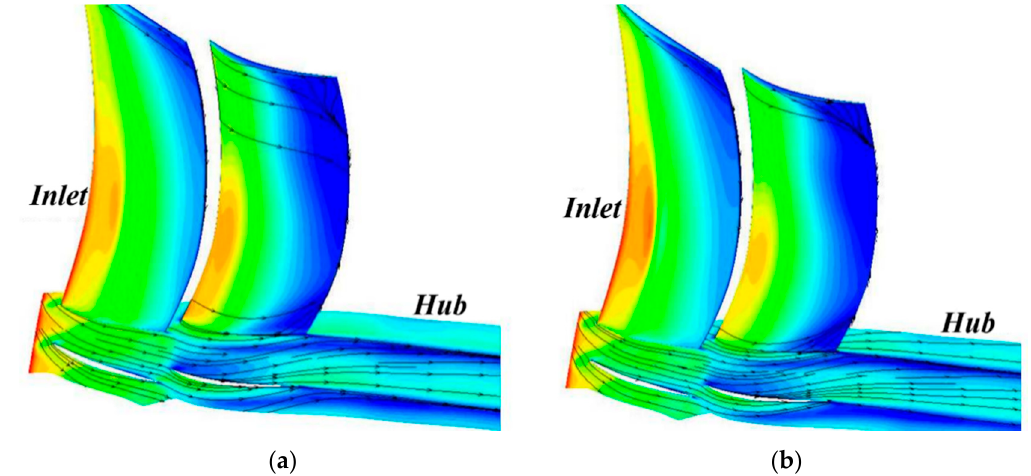
Figure 27. Mach contours near the blade surface at 100% design speed at the DE point. ( a ) Original; ( b ) modified.